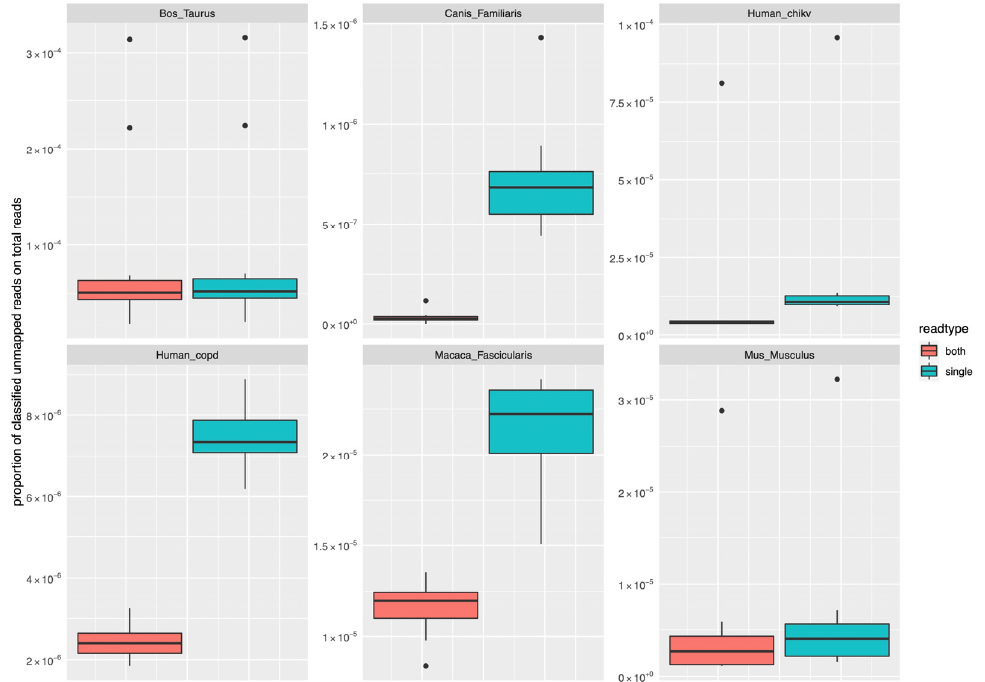
Figure 3. Proportion of reads assigned to microbial genera in different datasets, compared to the total number of reads in the sample. The figure illustrates the proportion of unmapped reads assigned to microbial genera in each of the test datasets. The reads are categorised by type, with “both” indicating those where both mates in the pair are unmapped, and “single” those where only one mate in the pair is unmapped.